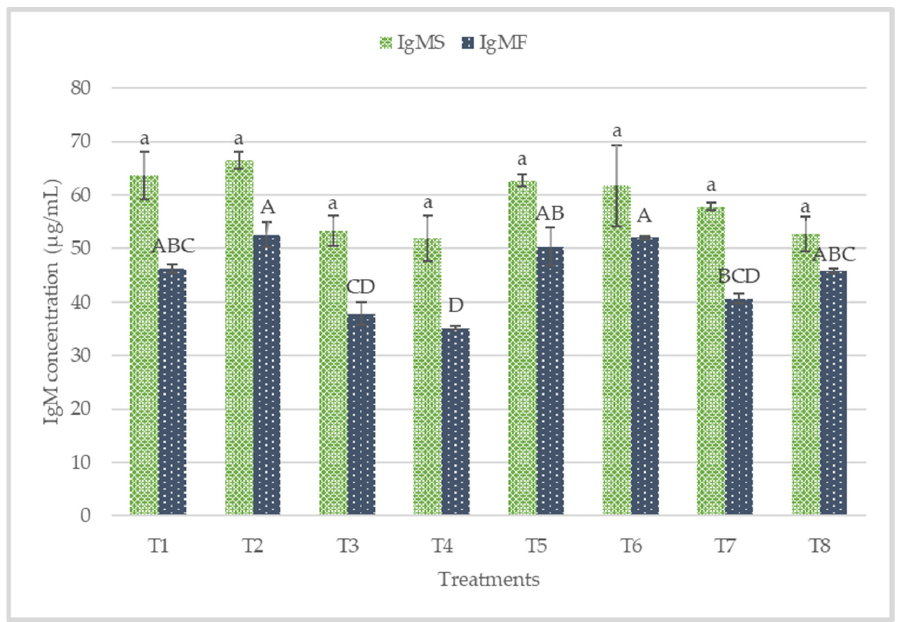
Figure 4. Plasma immunoglobulin concentrations of starter and finisher broiler chicken fed postbiotics and paraprobiotics. Bars with the same letters were not significantly different ( p > 0.05) for the IgM starter, while Bars with different letters are significantly different ( p < 0.05) for the IgM finisher, n = 6. T1 = negative control (Basal diet), T2 = positive control (Basal diet + 0.01% ( w / w ) Oxytetracycline), T3 = Basal diet + 0.2% ( v / w ) postbiotic TL1, T4 = Basal diet + 0.2% ( v / w ) postbiotic RS5, T5 = Basal diet + 0.2% ( v / w ) paraprobiotic RG11, T6 = Basal diet + 0.2% ( v / w ) postbiotic RI11, T7 = Basal diet + 0.2% ( v / w ) paraprobiotic RG14, T8 = Basal diet + 0.2% ( v / w ) paraprobiotic RI11. IgMS = Immunoglobulin M for starter, IgMF = Immunoglobulin M for finisher.